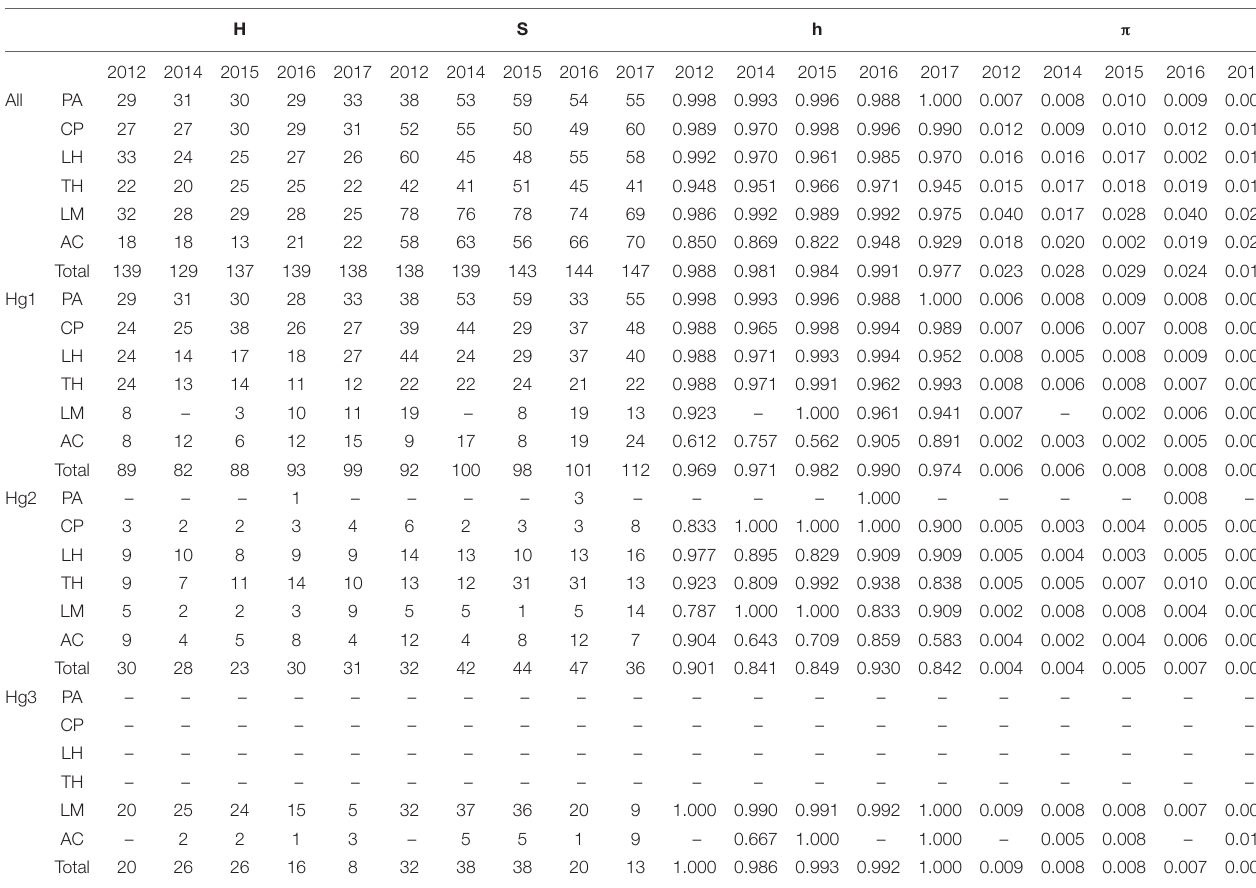
TABLE 1 | Genetic diversity measures for all COI data and for haplogroups 1 2, and 3 (Hg1, Hg2, and Hg3, respectively) of Pyura chilensis from five temporal samples (years 2012, 2014, 2015, 2016, and 2017). H S h